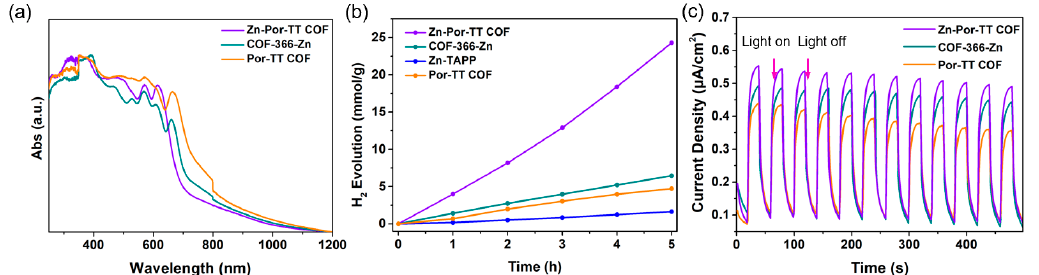
Figure 9. ( a ) DRS-UV spectra of Zn-Por-TT COF (violet), COF-366-Zn (cyan), and Por-TT COF (orange); ( b ) H 2 evolution rates of Zn-Por-TT COF (violet), COF-366-Zn (cyan), and Por-TT COF (orange); ( c ) photocurrent-time plots of Zn-Por-TT COF (violet), COF-366-Zn (cyan), and Por-TT COF (orange).